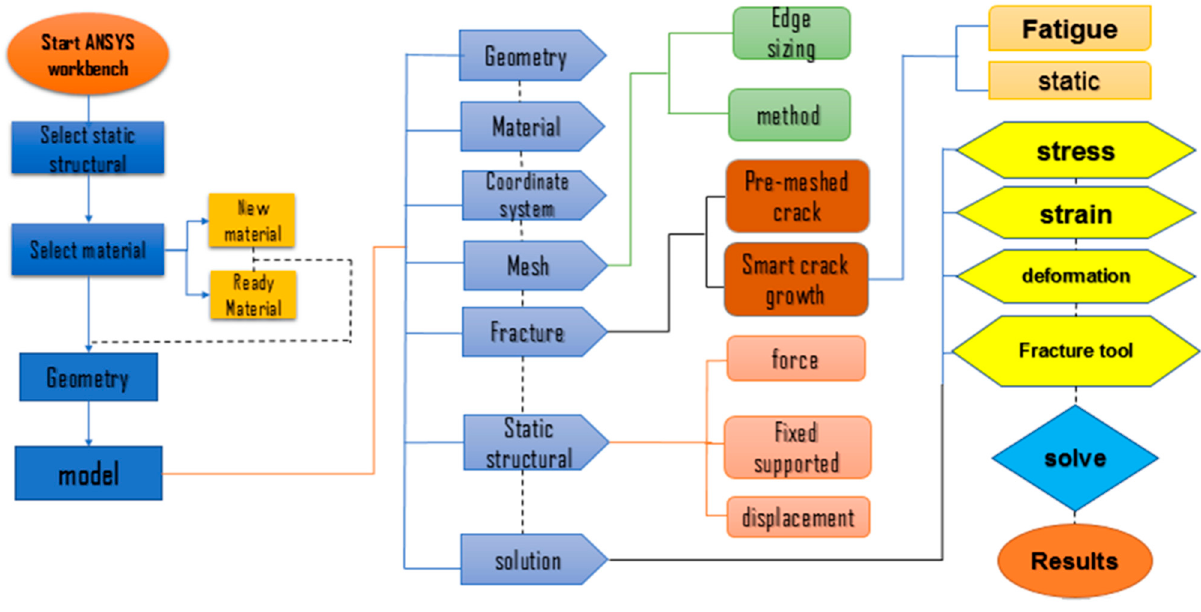
Figure 1. ANSYS flow chart for SMART crack growth simulations.